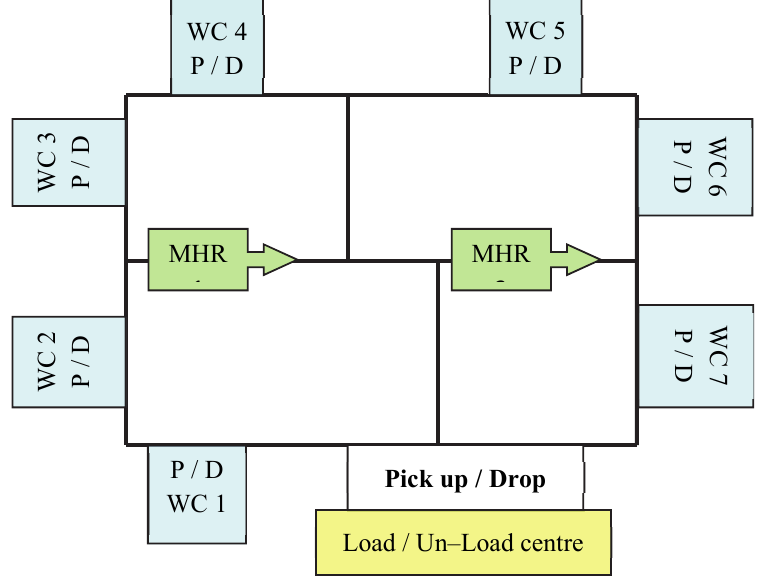
Fig. 3. The FMS layout 2 consisting of 7 work center and one load-unload center.